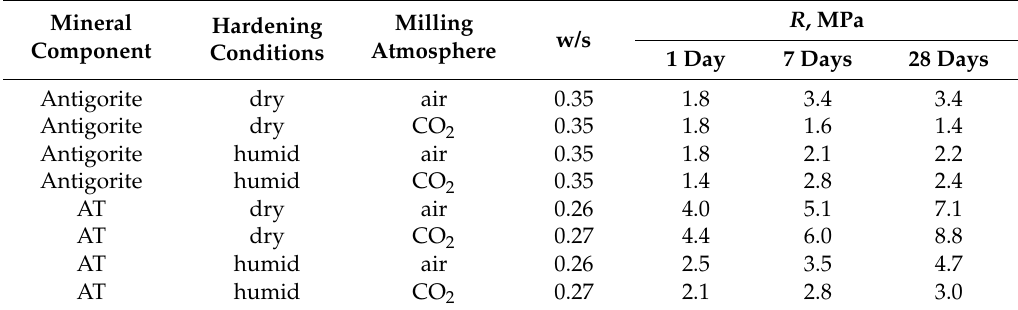
Table 3. Compressive strengths ( R ) of binders prepared using water and antigorite or antigorite-containing ore dressing tailings (AT) milled in moderate conditions for 600 s. (w/s: water to solid